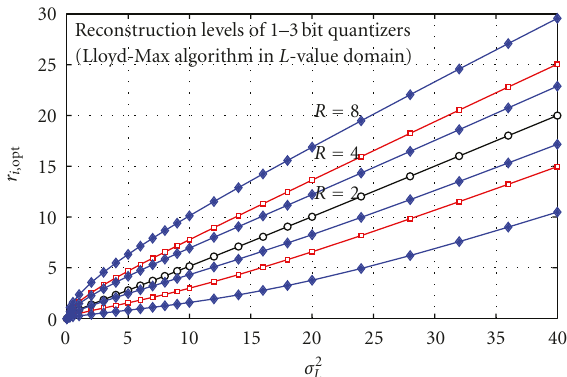
Figure 16: Optimum nonuniform quantization levels obtained by optimization in the L -value domain.